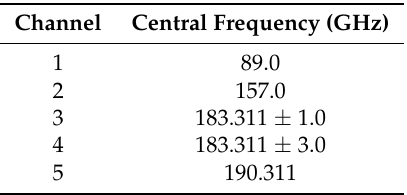
Table 1. Microwave Humidity Sounder (MHS) channels’